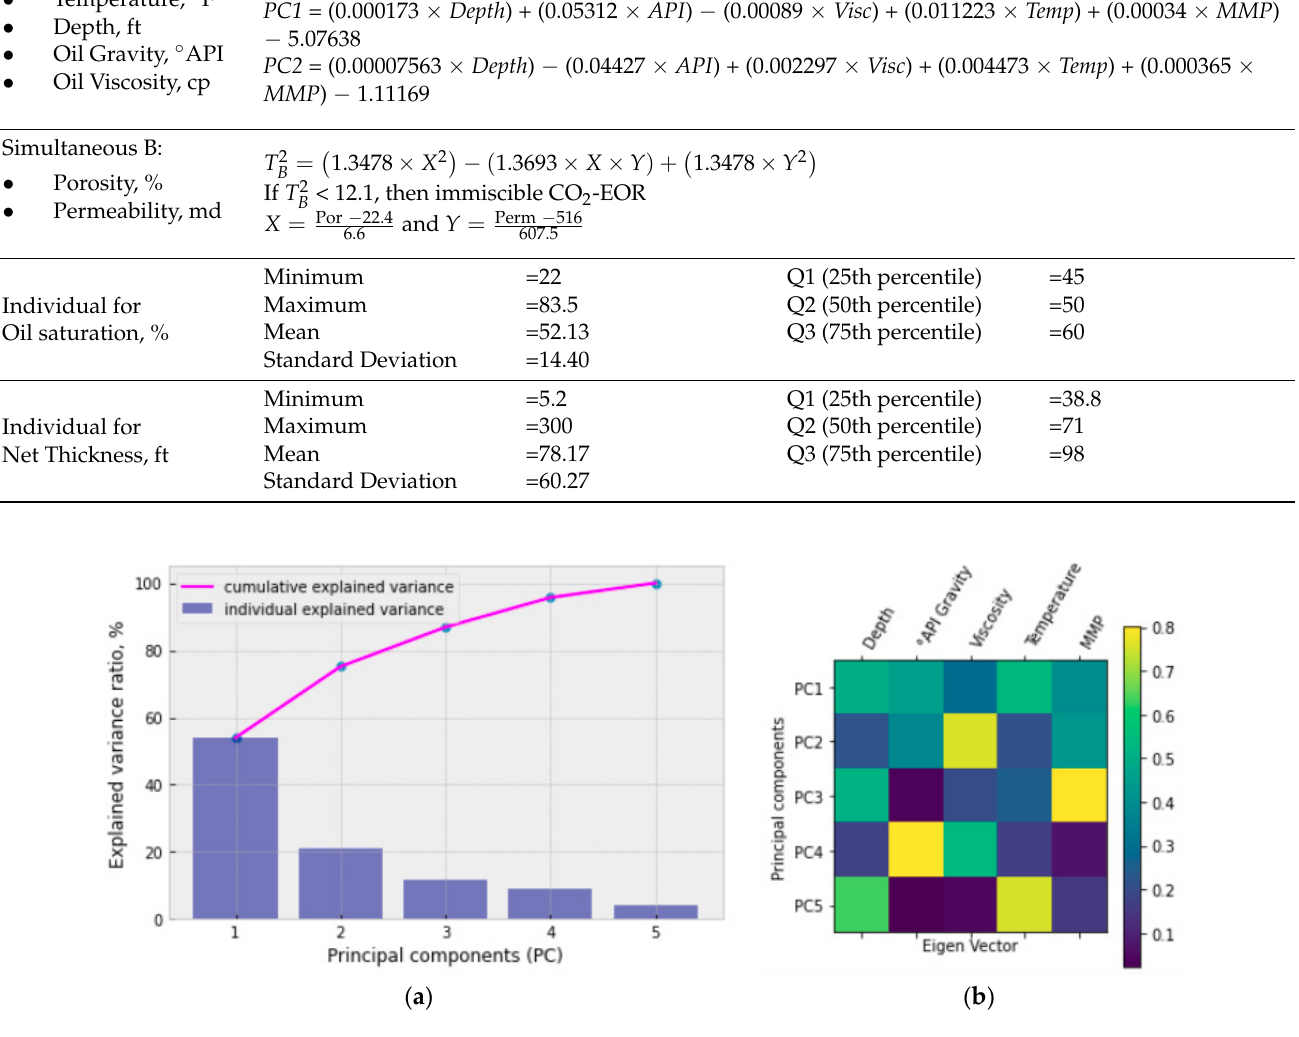
Figure 12. ( a ) Scree plot and ( b ) eigenvectors of PCA for immiscible CO 2 -EOR simultaneous screening model A. Table 4. Summary of the immiscible CO 2 -EOR screening model.